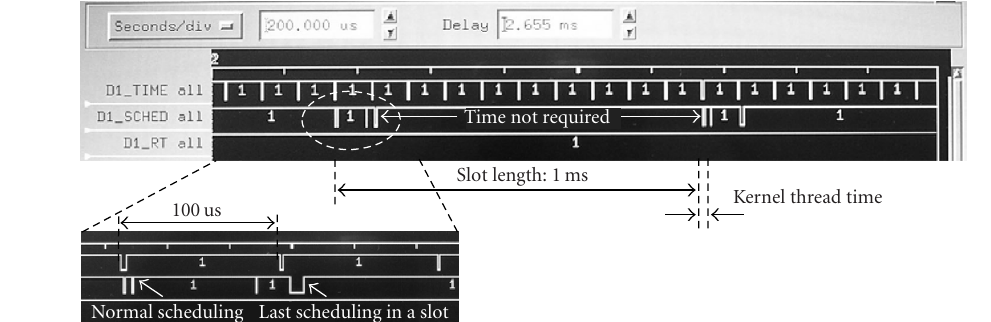
Figure 7: Timing diagram for DSP scheduling.